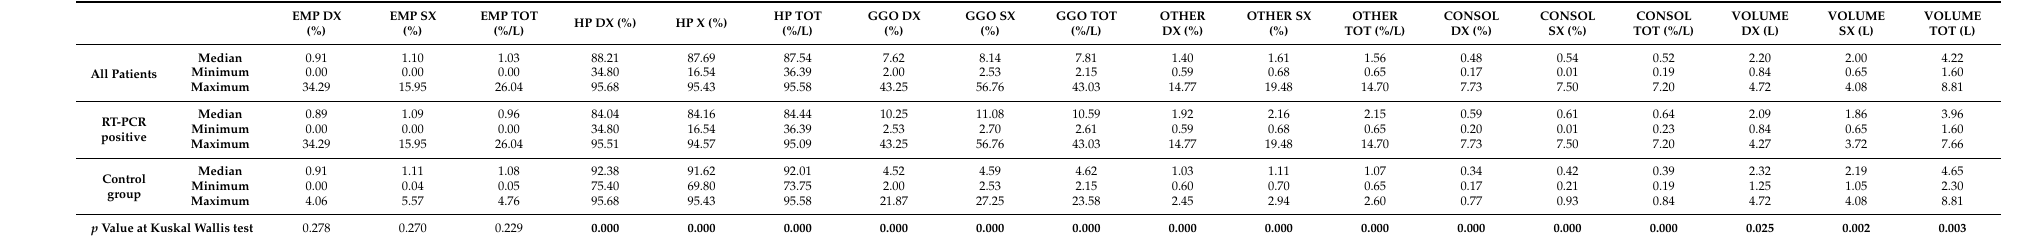
Table 5. Lung volumes quantified using the thoracic VCAR tool in terms of median, minimum, and maximum values obtained on baseline CT